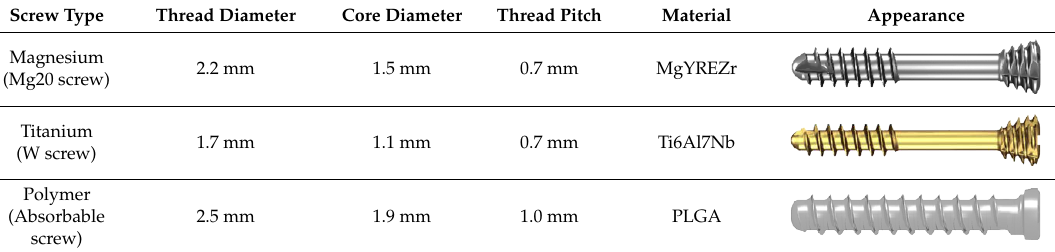
Figure 1. Examples of mechanical damage to the magnesium alloy screw. A and B—computed tomography images of the comminuted right head of the mandible ( A ) and images taken at the postoperative follow ‐ up ( B ). Operative field of the same patients ( C ): screws inserted through the lateral pool and posterior head surface, and three screws inserted below the lateral pool. The dexter caput mandibulae fractura is shown in the next picture to the right ( D ): simple case of a Type B head fracture. Four of the 20 screws used became deformed. The decalibration of the slot for the screwdriver was observed (1) in all of them, once the core bend of 1.7 screws and the breaking of 1.7 screws was observed (2). Decalibration of the slot is not dangerous if the operator is aware of such circumstances, and these types of incidents can occur after the screw has been placed in the final position; however, bending and breaking of the screw compromises the integrity of osteosynthesis. All screws presented here are 1.7 mm system headless compressive screws (i.e., before the modification was tested in this study). Table 1. Comparison of 14 mm screws made by one manufacturer. All the screws shown below are used specifically for osteosynthesis of the mandible condylar head.